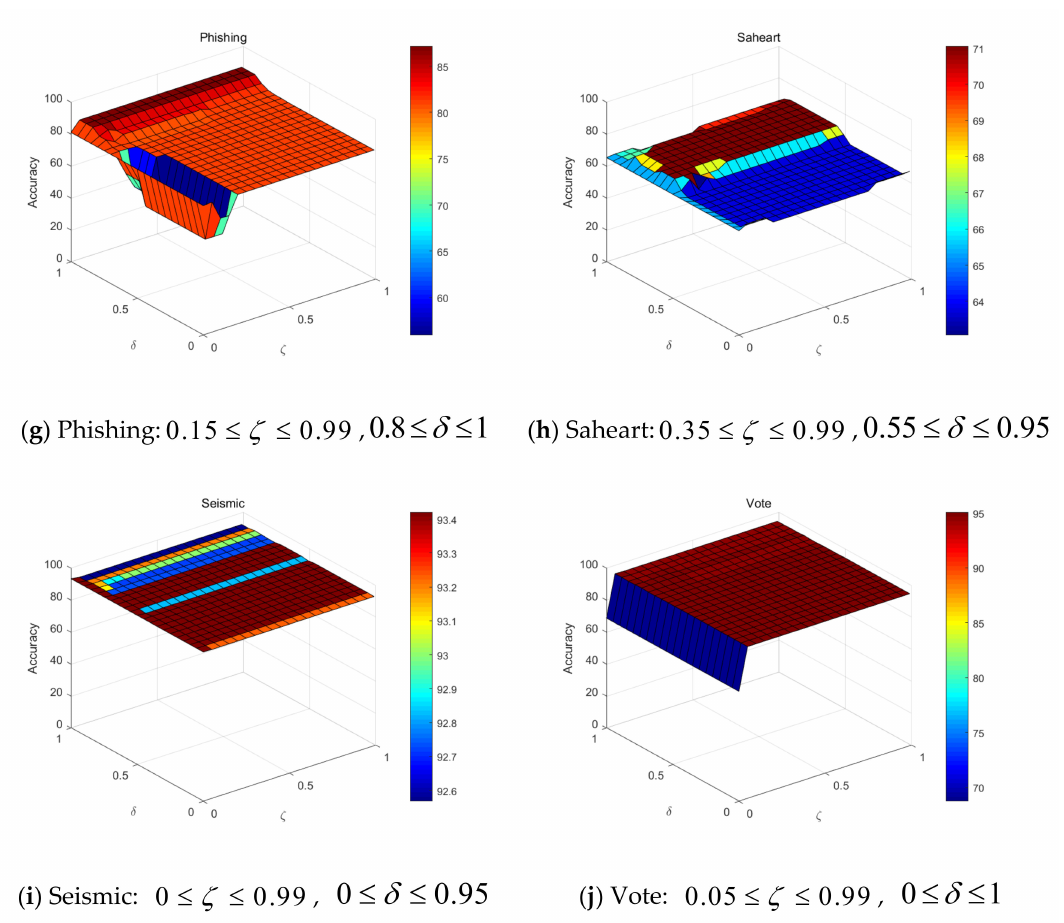
Figure 3. The accuracy results of ζ and δ with respect to FN ζ